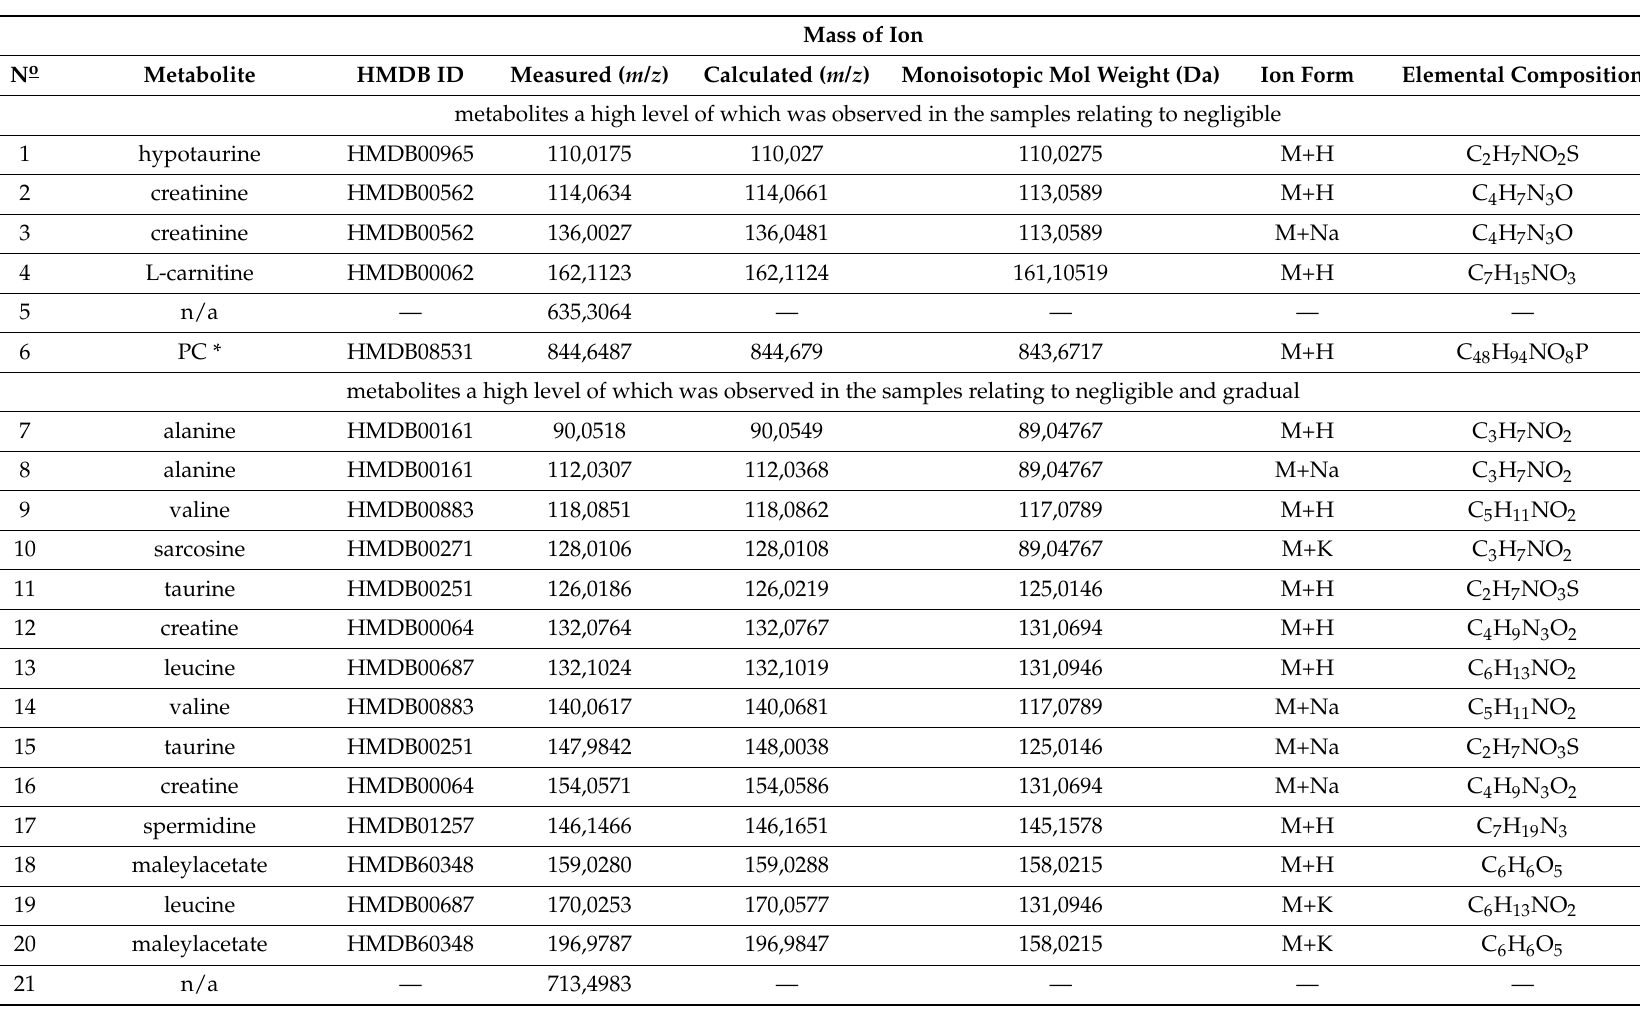
Table 1. Distinctive m / z features and putatively identified skeletal muscle metabolites typical for fish species with different lifespan. Mass of Ion Elemental Composition metabolites a high level of which was observed in the samples relating to